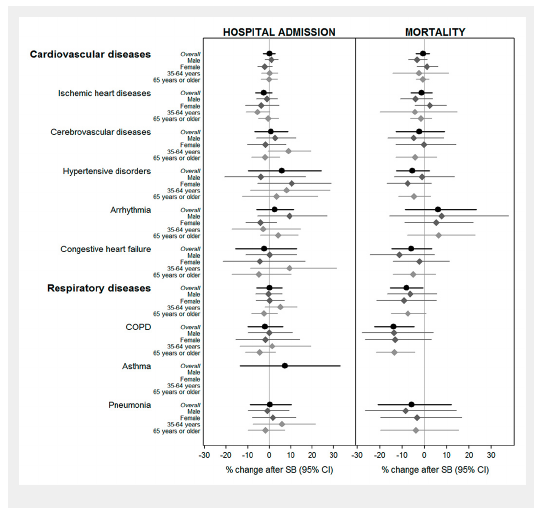
Gender- and age-specific estimates of percentage (and 95% confidence intervals, CIs) change in hospital admissions and mortality in adults (≥35 years old) by the main groups of causes after the introduction of the smoking ban (data restricted to the periods 2 years before and 2 years after the introduction of the smoking ban in each